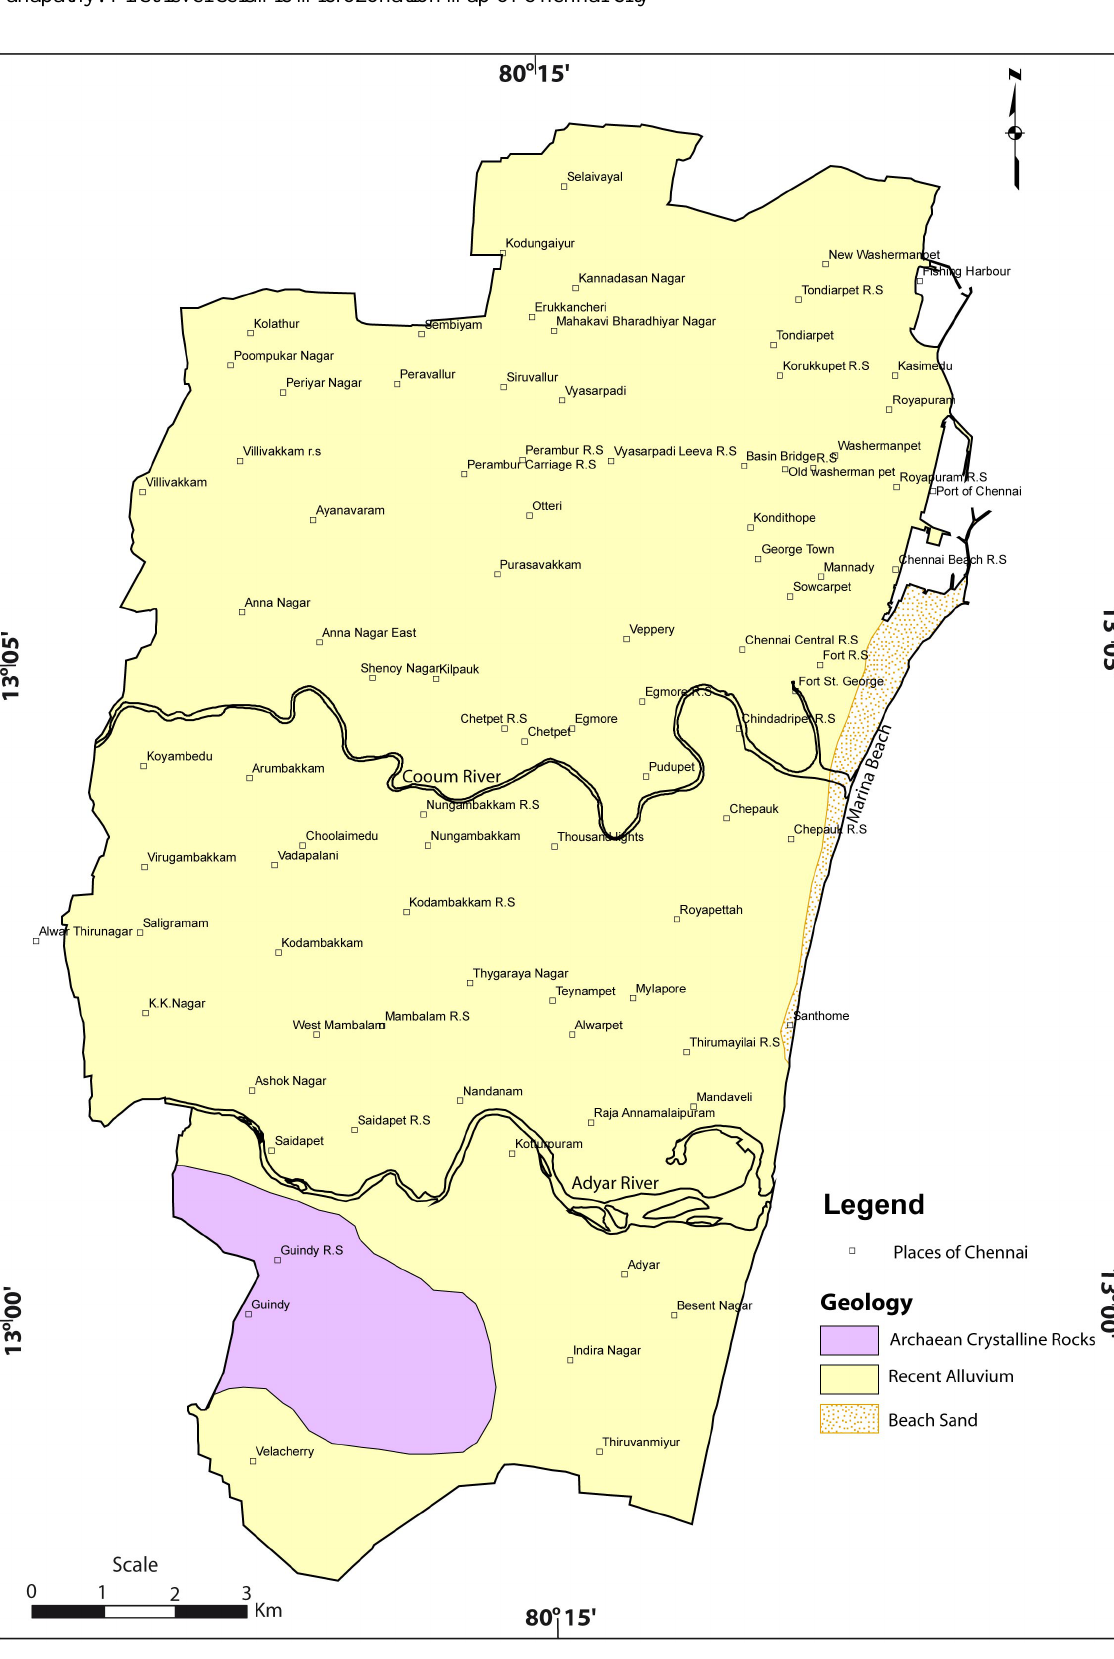
Fig. 5. Geology of Chennai